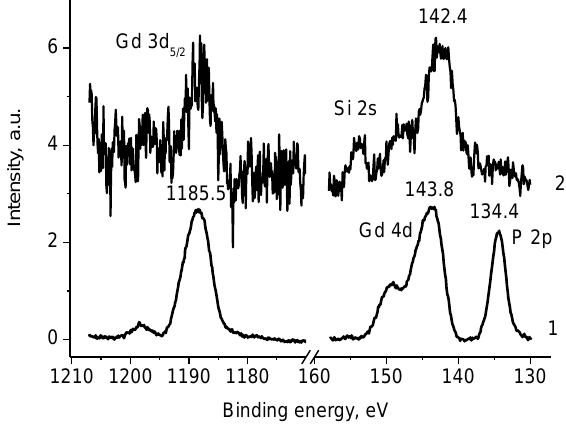
Figure 26. The Gd 3d photoelectron spectra of samples Pt/1′ (1) and 2 (2). The Zr 3d spectrum in Figure 27 was fitted with two spin-orbit doublets at binding energies of 179.4/181.8 and 182.4/184.8 eV with relative intensities 0.69 and 0.31, which may be assigned to Zr + and Zr 4+ states.